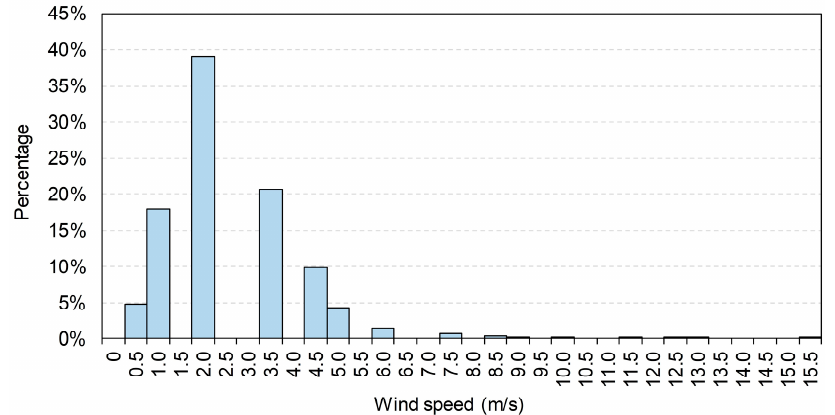
Figure 14. Distribution of the hourly wind speed data of Wuhan from 1 January 2019, to 31 March 2019.